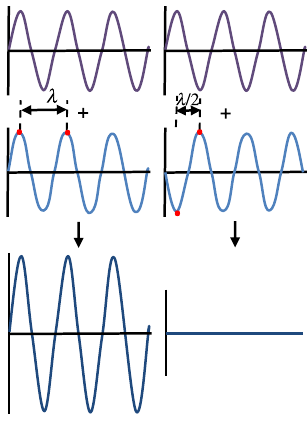
FIG. 2. CTapproach: Visualizing the processes that underlie the occurrence of maxima and minima in double-slit interference.